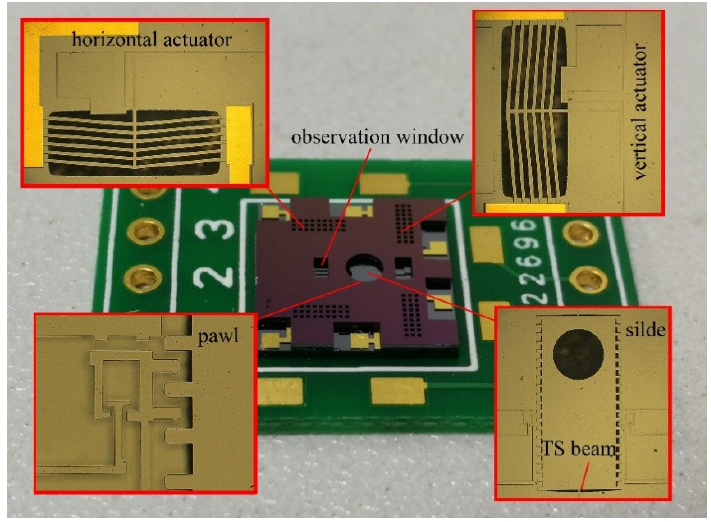
Figure 10. Detail structure of the S&A device.